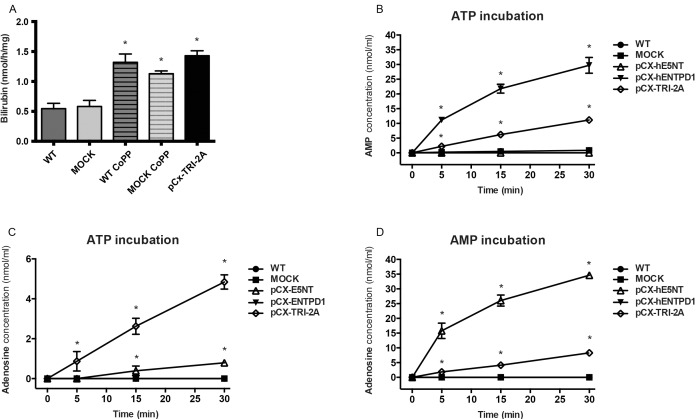
Heme oxygenase-1 and ectonucleotidases functional assays.(A) Heme Oxygenase 1 activity assay on NIH3T3 cells. Lysates from WT, mock- and pCX-TRI-2A-transfected cells were incubated for 2 hours with Hemin, BSA, Biliverdin Reductase A in reaction buffer as described in Materials and Methods. As positive control of the assay, wt or mock-transfected cells were pre-stimulated with 50 μM of HO1 inducer, Cobalt Protoporphyrin for 24 hours (wt CoPP, mock CoPP). Enzymatic activity is reported as nanomoles of bilirubin per hours per milligrams of protein extract. Data are expressed as mean ± SEM of 3–4 independent experiments. *p<0.05 versus wt and mock-transfected cells. (B) ENTPD1-mediated AMP production and (C) E5NT-mediated adenosine production by wild type, mock and pCX-TRI-2A transfected-cells. Cells were incubated with 50 μM ATP for 30 min. The nucleotide content of supernatants collected at 0, 5, 15, 30 min time points was measured by reverse phase-HPLC as detailed in Material and Methods. Data shown are mean ± S.D. (n = 3). *p<0.05 versus all groups. (D) E5NT-mediated adenosine production by wild type, mock and transfected-cells. Cells were incubated with 50 μM AMP for 30 min. The nucleotide content of supernatants collected at 0, 5, 15, 30 min time points was measured by reverse phase-HPLC ad detailed in Material and Methods. Data shown are mean ± S.D. (n = 3). *p<0.05 versus all groups.